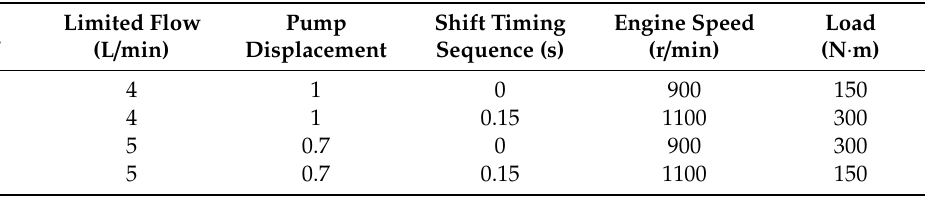
Table 2. Test scheme of the power shift.